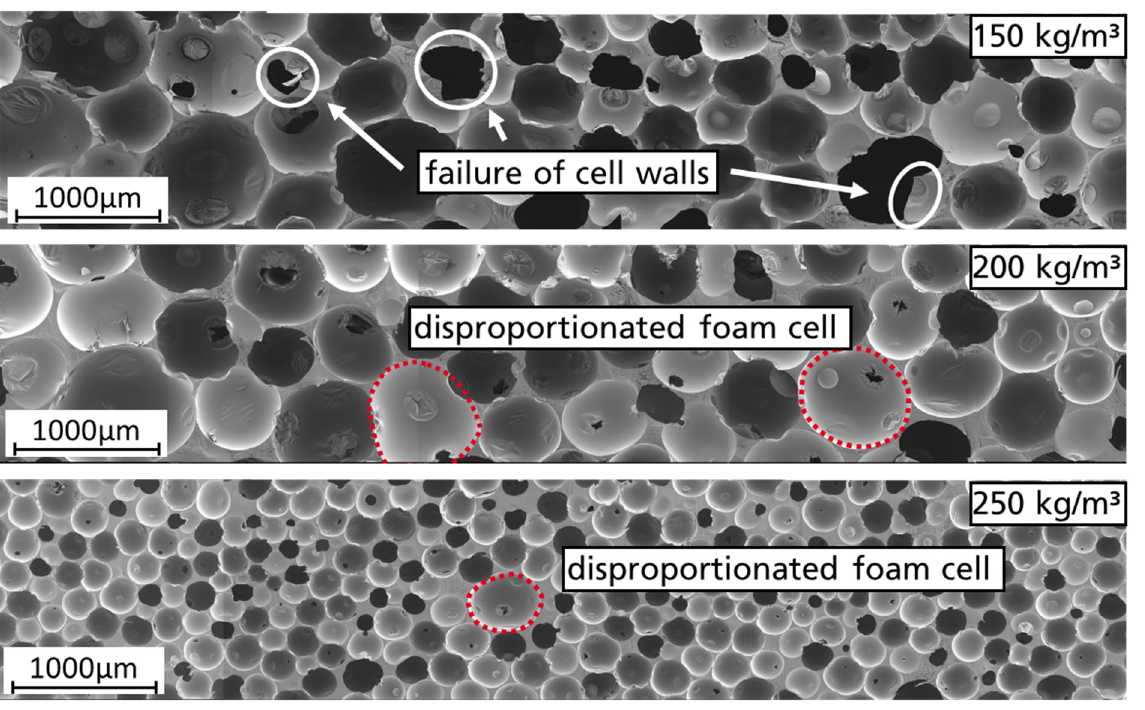
Figure 10. PUR foam morphology at 150 kg/m 3 (top), 200 kg/m 3 (middle) and 250 kg/m 3 (bottom) foam density.